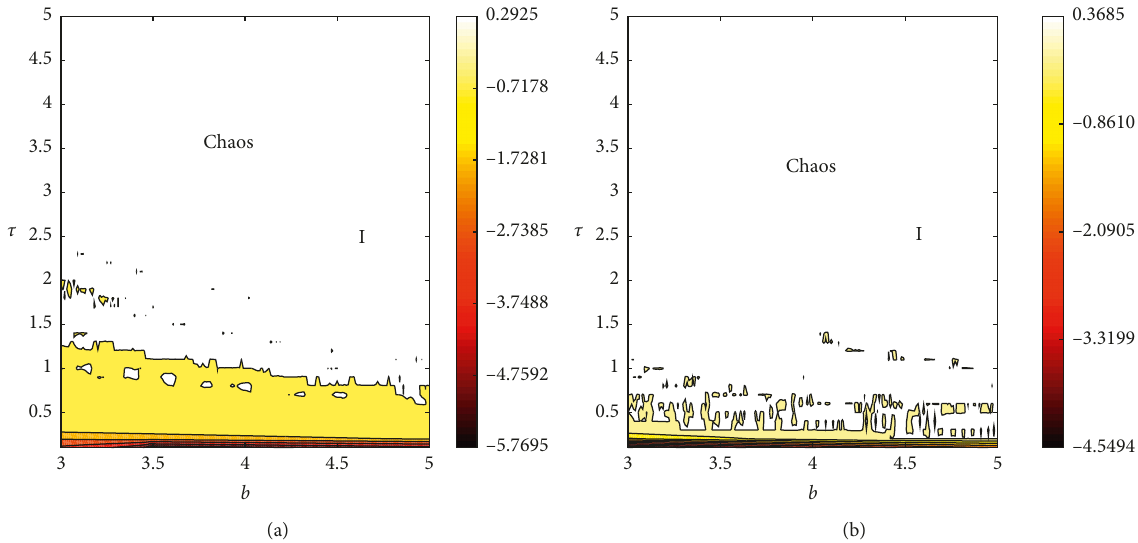
Figure 10: (a) The 2D LE diagram showing the largest Lyapunov exponent ( λ diagram showing the largest Lyapunov exponent of the ACCM-Ikeda TD system in the ( b − τ )